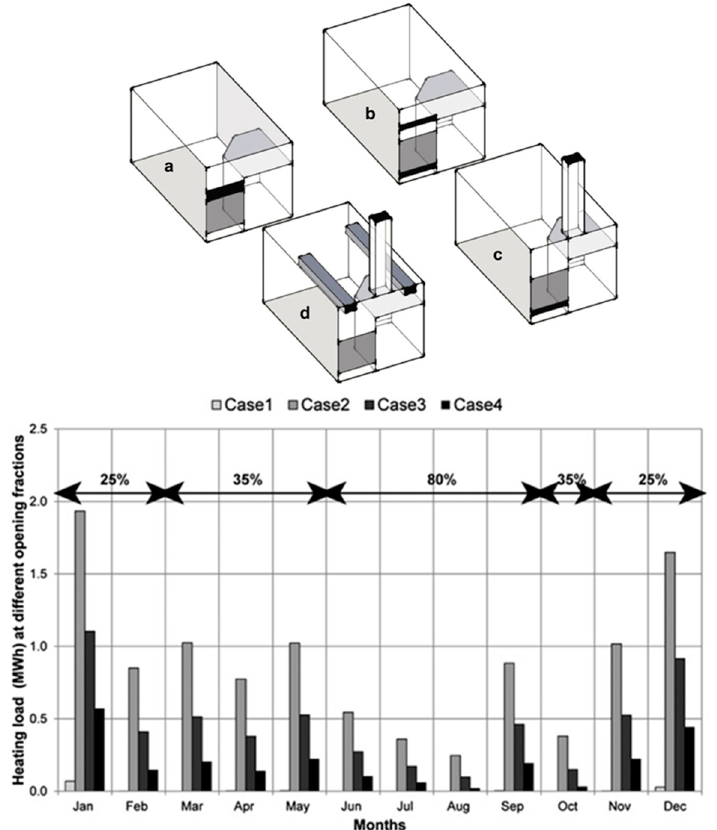
Figure 5. Monthly heating loads with different opening fractions. ( a ) Single window opening (Case 1), ( b ) same-side dual opening (Case 2), ( c ) inlet and stack (Case 3), and ( d ) ceiling-based natural ventilation (Case 4) [18].